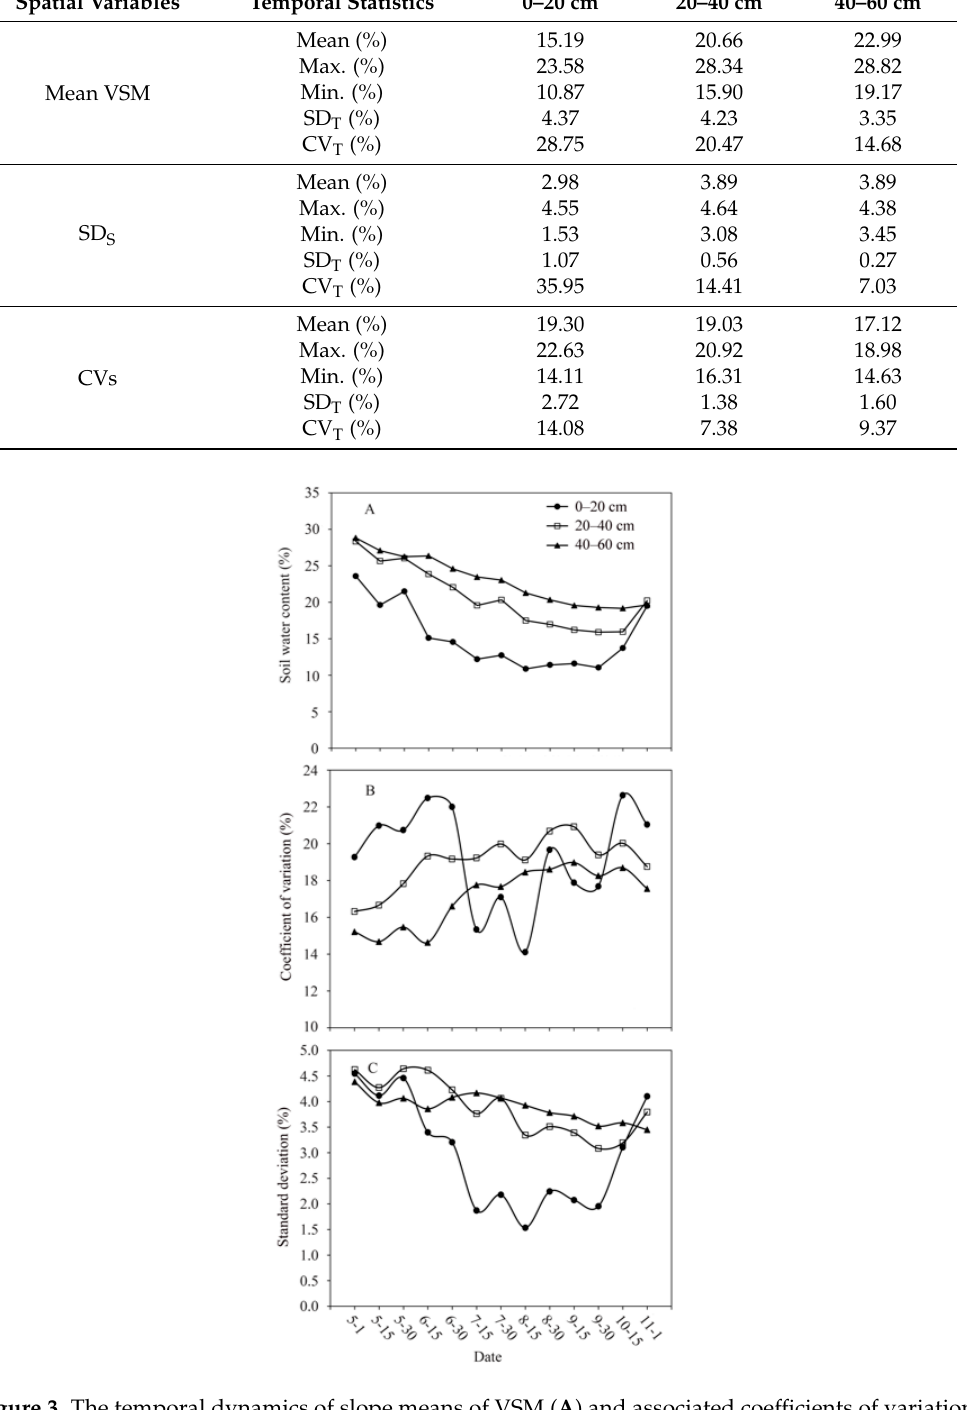
Figure 3. The temporal dynamics of slope means of VSM ( A ) and associated coefficients of variation ( B ) and standard deviations ( C ) in different soil layers.